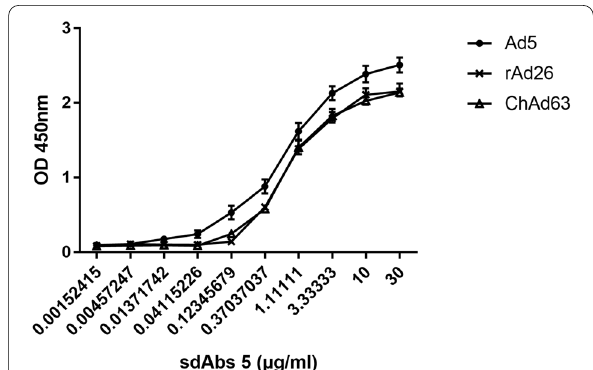
Fig. 9 The binding activity of recombinant sdAbs 5 to three adenoviruses was analyzed using a typical ELISA. Recombinant sdAbs 5 showed binding activity to human adenovirus Ad5, rAd26 and ChAd63 viruses in ELISA at concentrations from 30 μg/ml to 0.00152415 μg/ml